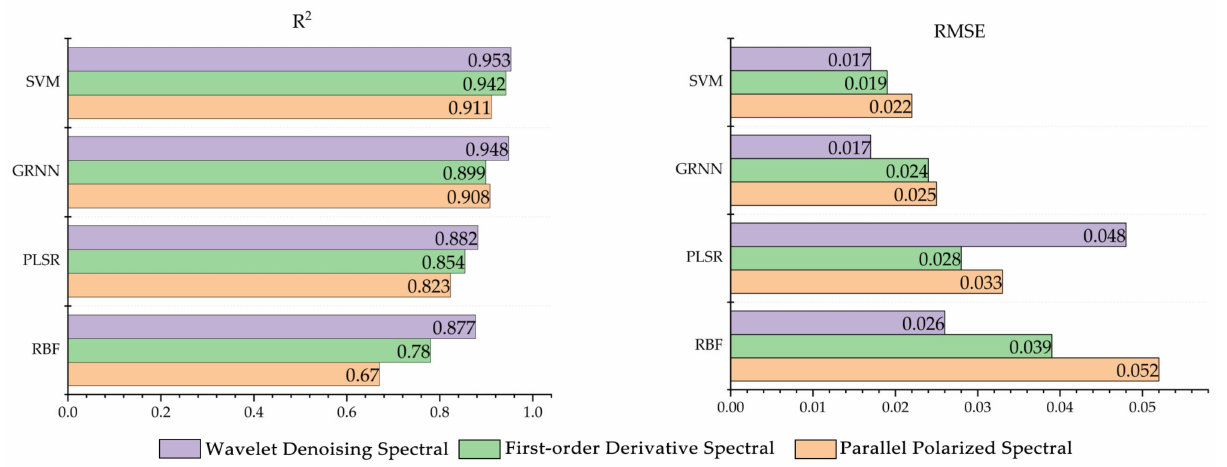
Figure 10. Comparative analysis of R 2 and RMSE of three spectral data